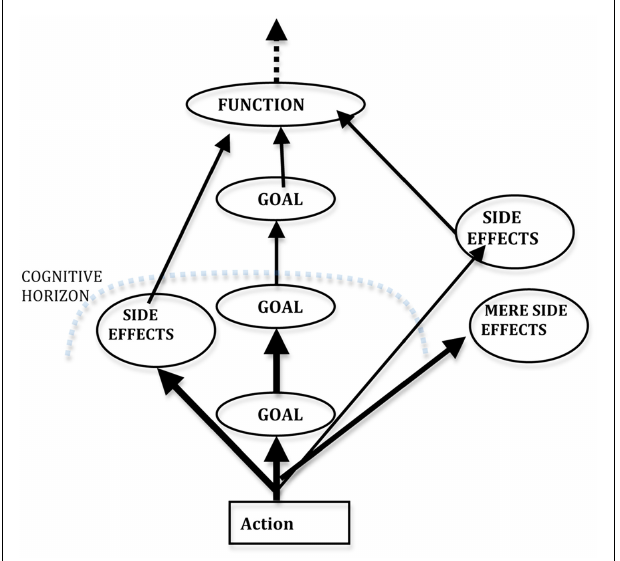
FIGURE 2 | Mental Goals and possible